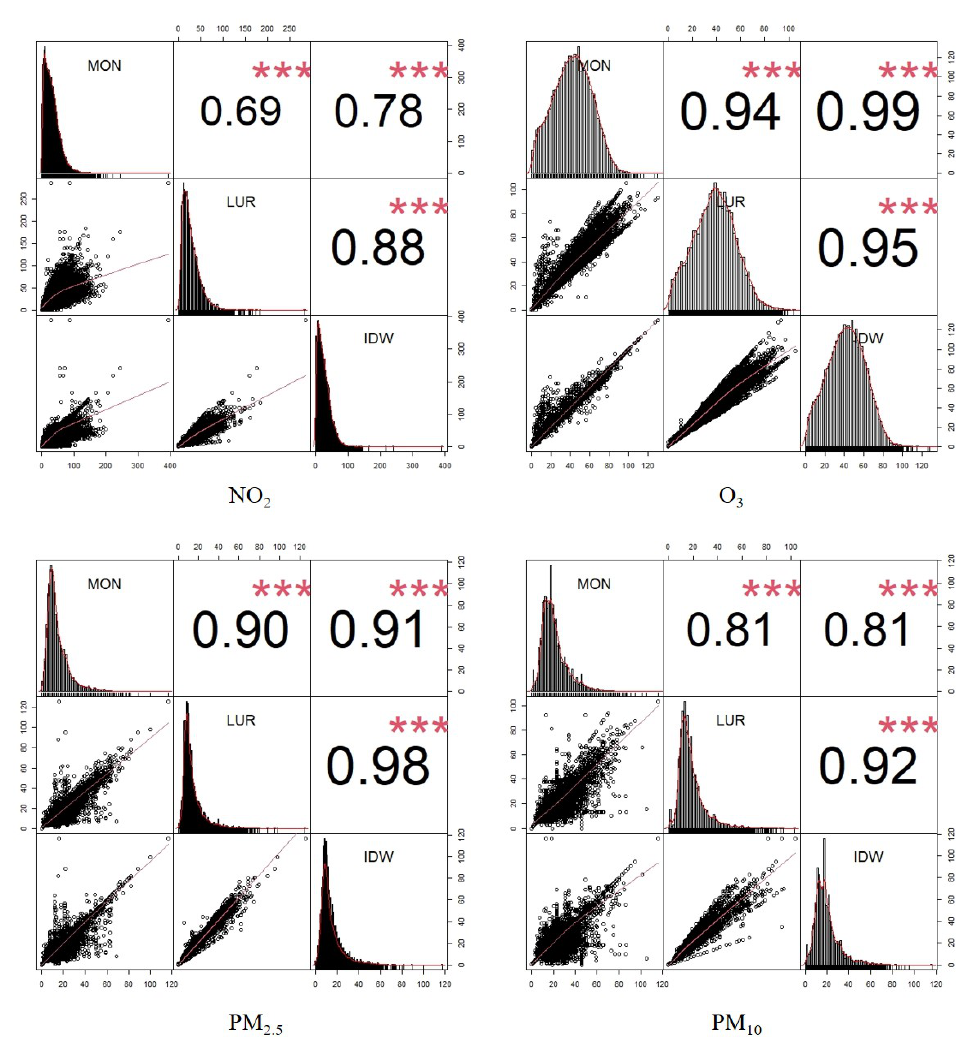
Figure 2. Pairwise scatter plots (bottom-left cells), histograms of concentrations’ distribution (left diagonal), and Person coefficients (top-right cells) for daily concentrations of NO 2 , O 3 (top row), PM 2.5 , and PM 10 (bottom row). It shows paired comparisons of monitored daily concentrations (MONs), estimated daily concentrations based on LUR scaling (LUR), and estimated daily concen- trations based on IDW (IDW). All correlations are significant. Note that this is a naive comparison at monitoring stations, which does not reflect the accuracy of estimates in out-of-sample areas as the IDW concentrations are entirely based on measurements from nearest monitors within a 50 km radius. Stars represent p -values: *** p <